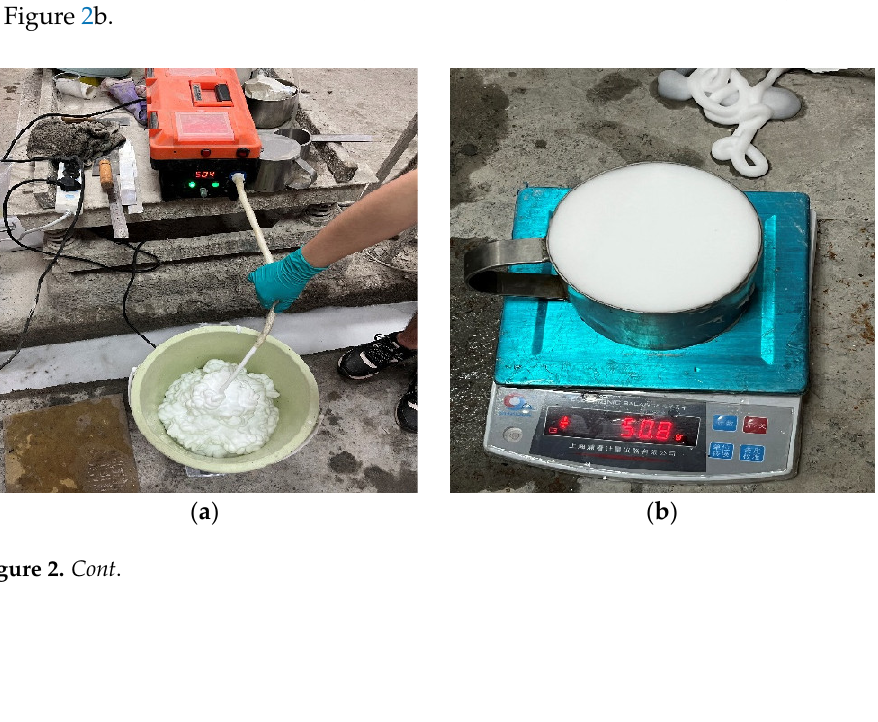
Table 4. Compounding ratios for FLS (kg/m 3